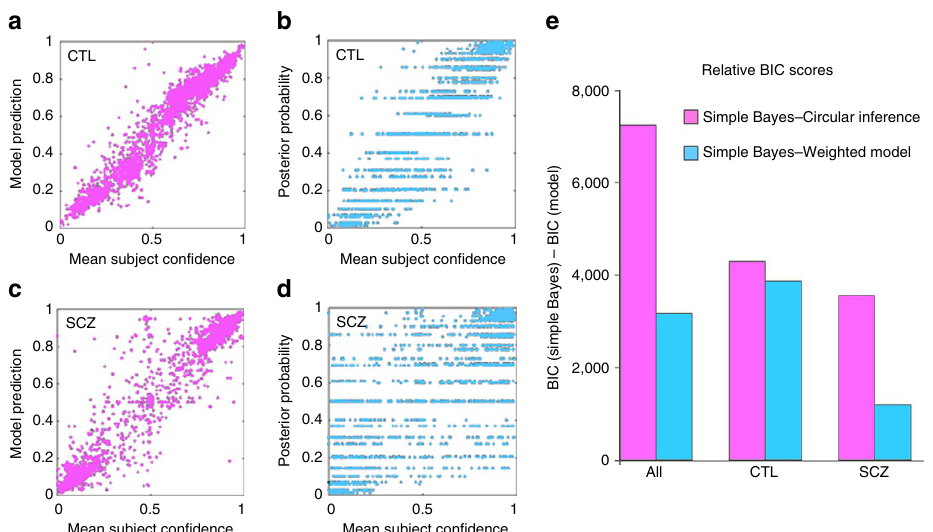
Figure 4 | Quality of the model fits. The predictions of the circular inference model (including the weights and loops, shown in purple) are presented for the CTLs ( a ) and for the patients with SCZ ( c ); the predictions of the simple Bayes model are presented for the CTLs ( b ) and the patients with SCZ ( d ; shown in sky blue). The relative gain of the implemented optimisation steps (that is, weights and loops) was determined using relative BIC scores ( e ). The BIC score of the circular inference model (in purple) and the reduced weighted Bayes model (without loops, in blue) was compared with that of the simple Bayes model. The circular inference model optimally captured the heterogeneity of the SCZ sample ( c , e ).